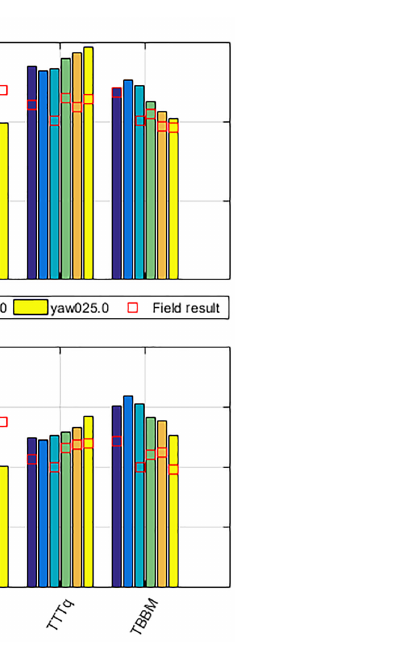
Figure 12. Comparison between predicted (FAST, bars) and measured (field, square symbols) mean DELs as a function of yaw offsets for mean U hub = 10ms − 1 (a) and 14ms − 1 (b) . DELs are normalized by their respective mean values at 0 ◦ yaw offset as calculated from the field measurements for the respective wind-speed